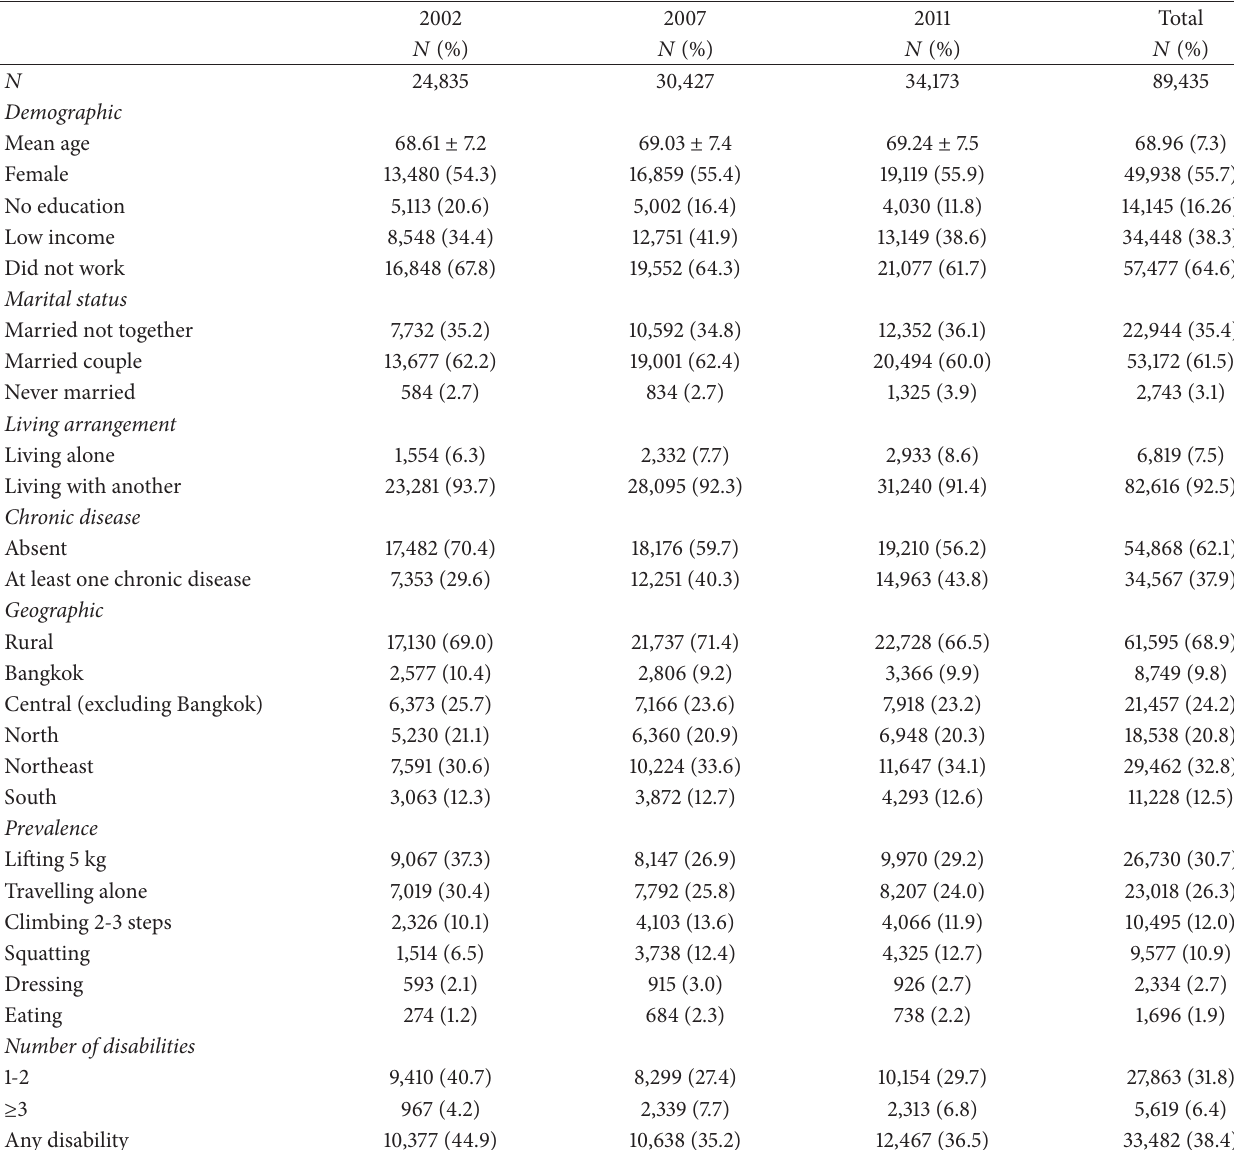
Years. Table 4 demonstrated the associations of subject char- acteristics with disability risk. As expected, age indicated